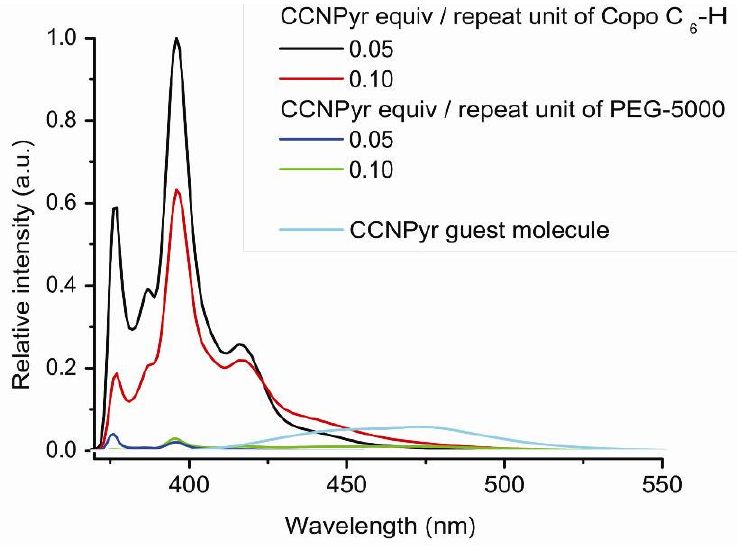
Figure 9. Photoluminescence spectra (emission mode, excitation at 317 nm) of -H/CCNPyr and PEG-5000/CCNPyr in the solid “host-guest” materials Copo C 6